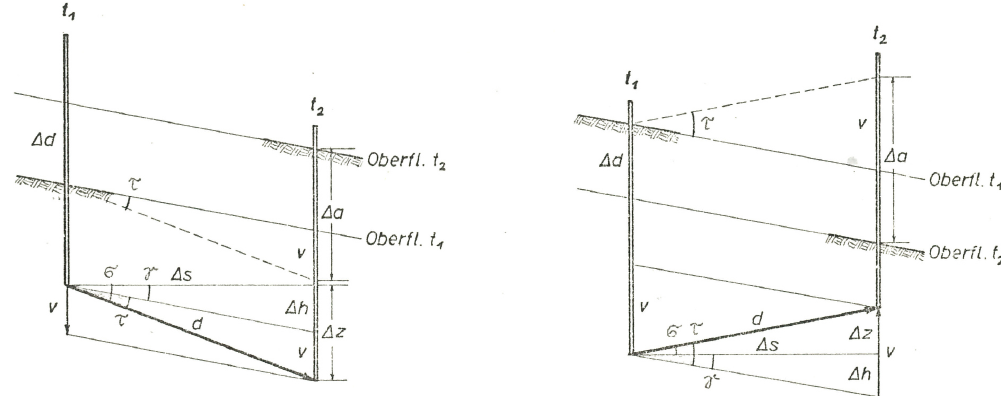
Figure 2. Drawings by Schneider (1970) of the motion of a stake and changes at the glacier surface (Oberfl.) between two time steps (t1, t2) within the accumulation area (left) and the ablation area (right). d : flow path (length of the velocity vector); v : vertical velocity; (cid:49)s : horizontal velocity (projected velocity); (cid:49)d : absolute surface elevation change; (cid:49)a : point mass balance (relative surface elevation change from accumulation or